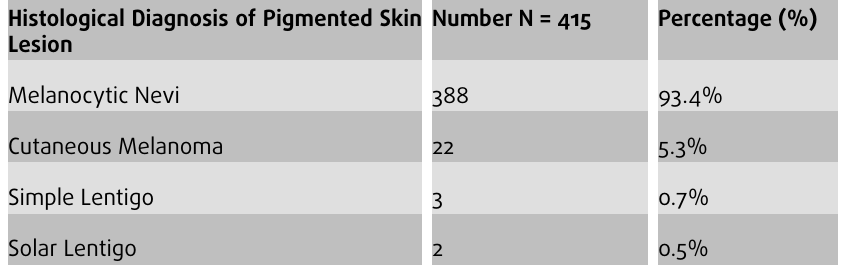
Table 1: Number and percentage of pigmented skin lesions among patients attending KAAUH between January 2000 and December